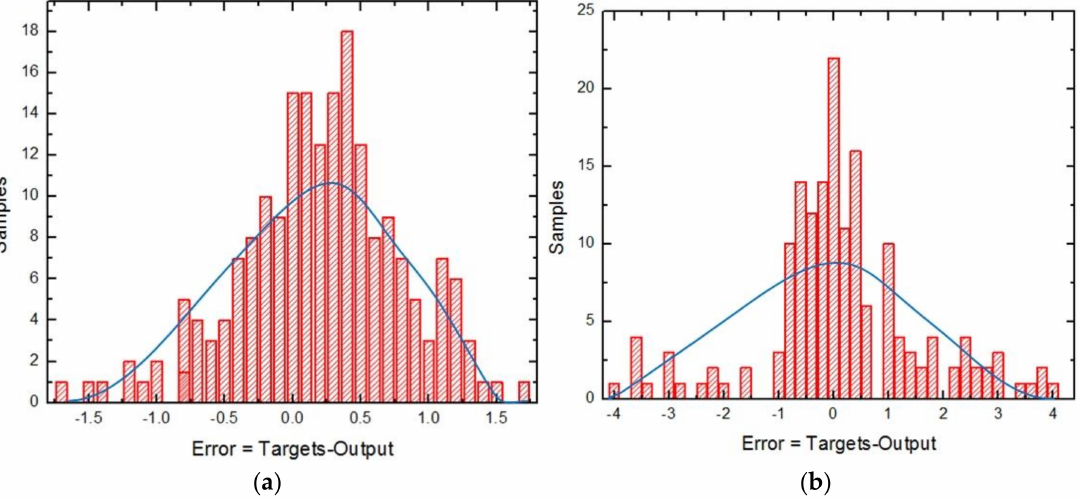
Figure 5. Heating load and cooling load histogram testing error. ( a ) Heating load, ( b ) cooling